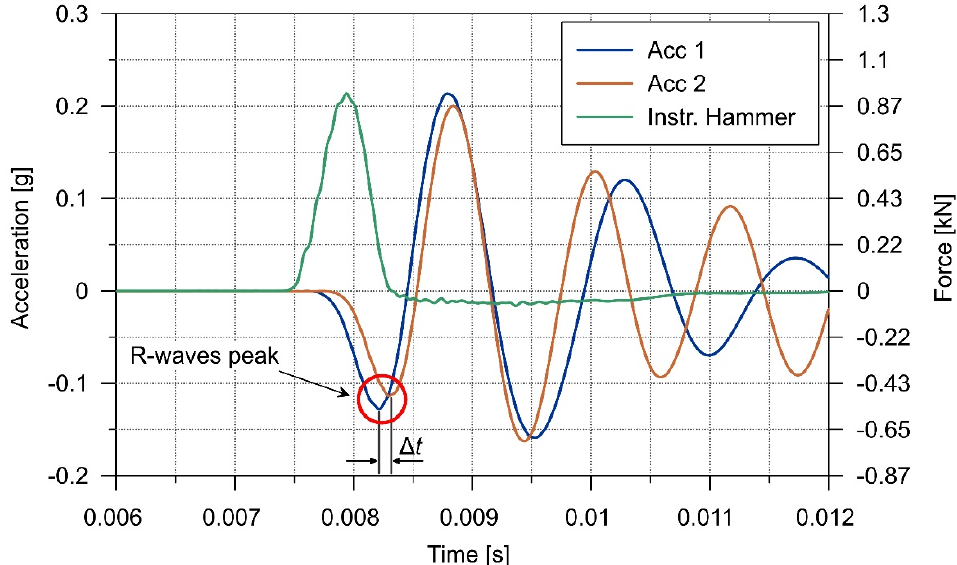
Figure 4. Typical values recorded by the accelerometers in the tests on the wall CLS 1. One of the points taken as a reference for the passage of R-waves is highlighted in the graph. The distance between the point of impact and the registration point is 20 cm.